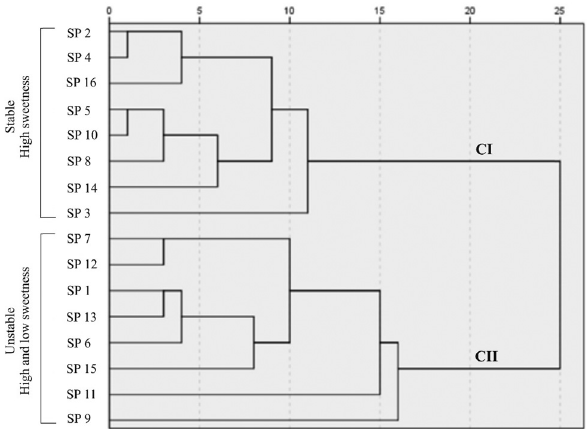
Figure 4: Dendrogram of sweetness character on 16 honey sweet potato genotype based on stability